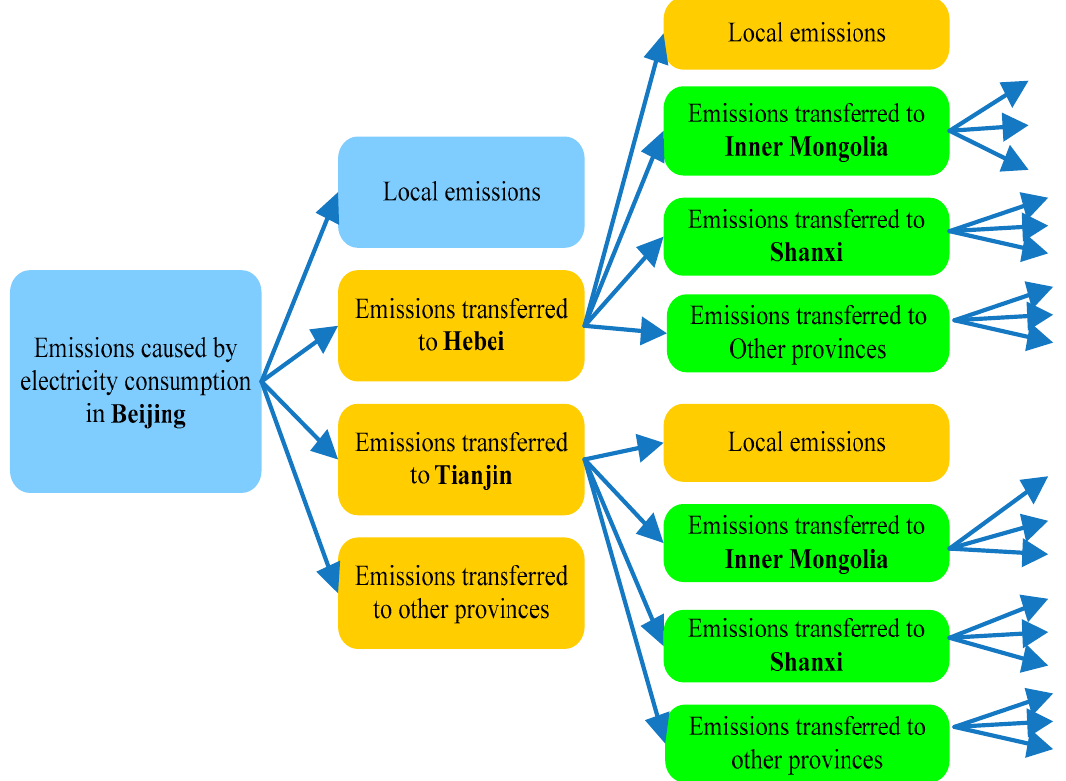
Figure 3. The structure of emissions caused by electricity consumption in Beijing.